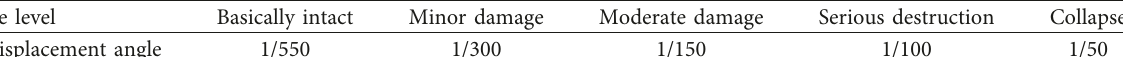
Table 5: Structural performance levels and quantitative